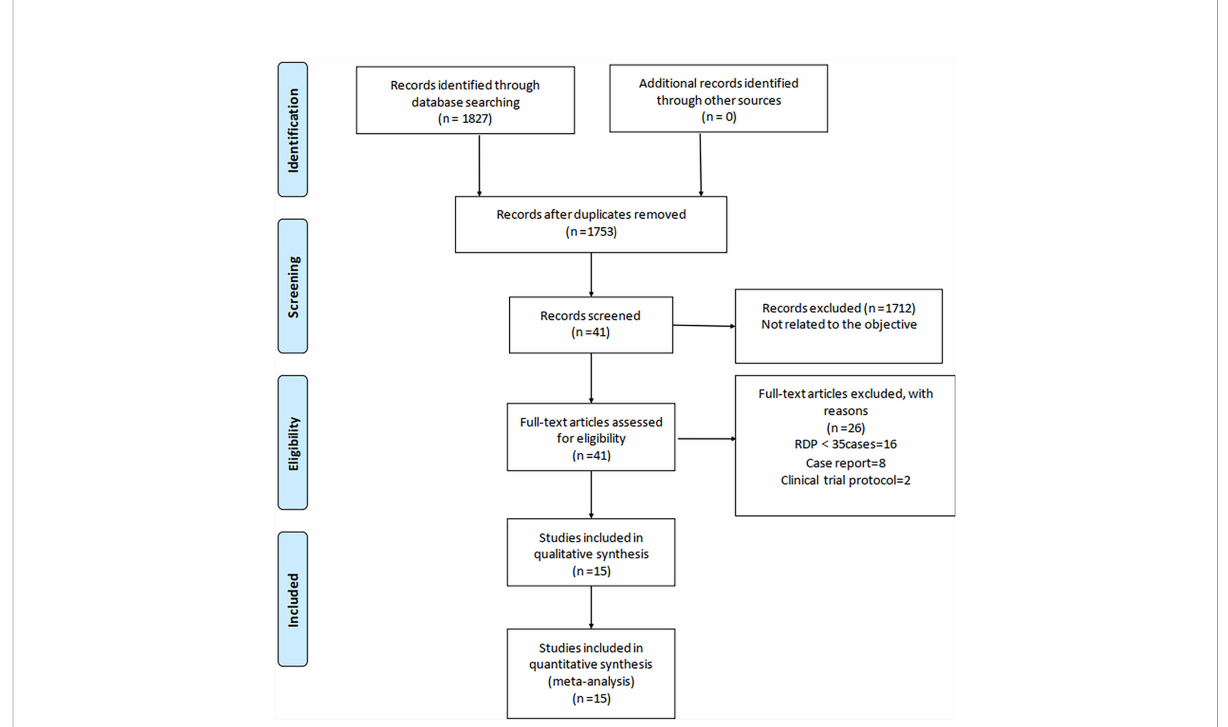
FIGURE 1 Flowchart of study identi fi cation and